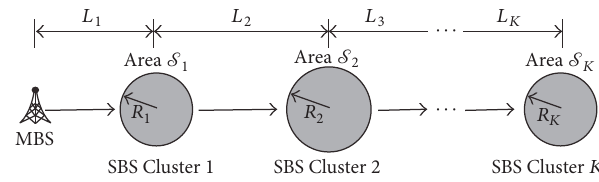
Figure 2: Multihop wireless